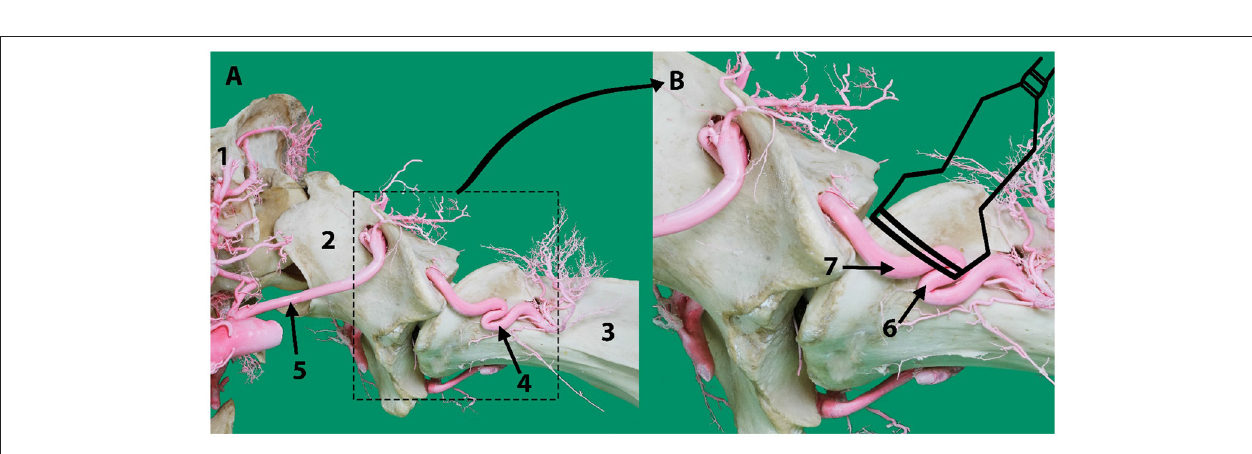
FIGURE 2 | (A) Lateral aspect of an arterial resin cast showing the external route of the vertebral artery relative to cervical vertebrae C1 (atlas) and C2 (axis). (B) An outline of the transducer probe is superimposed over the location of the vertebral artery to explain the presence of the two colors in Figure 1C indicating the blood flow toward (6) and away (7) from the transducer due to the curved route of the vertebral artery in this area. Here 1, skull; 2, atlas; 3, axis; 4, vertebral artery; 5, occipital